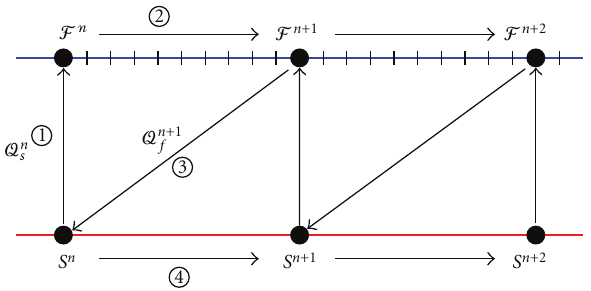
Figure 2: Partitioned coupling algorithm.